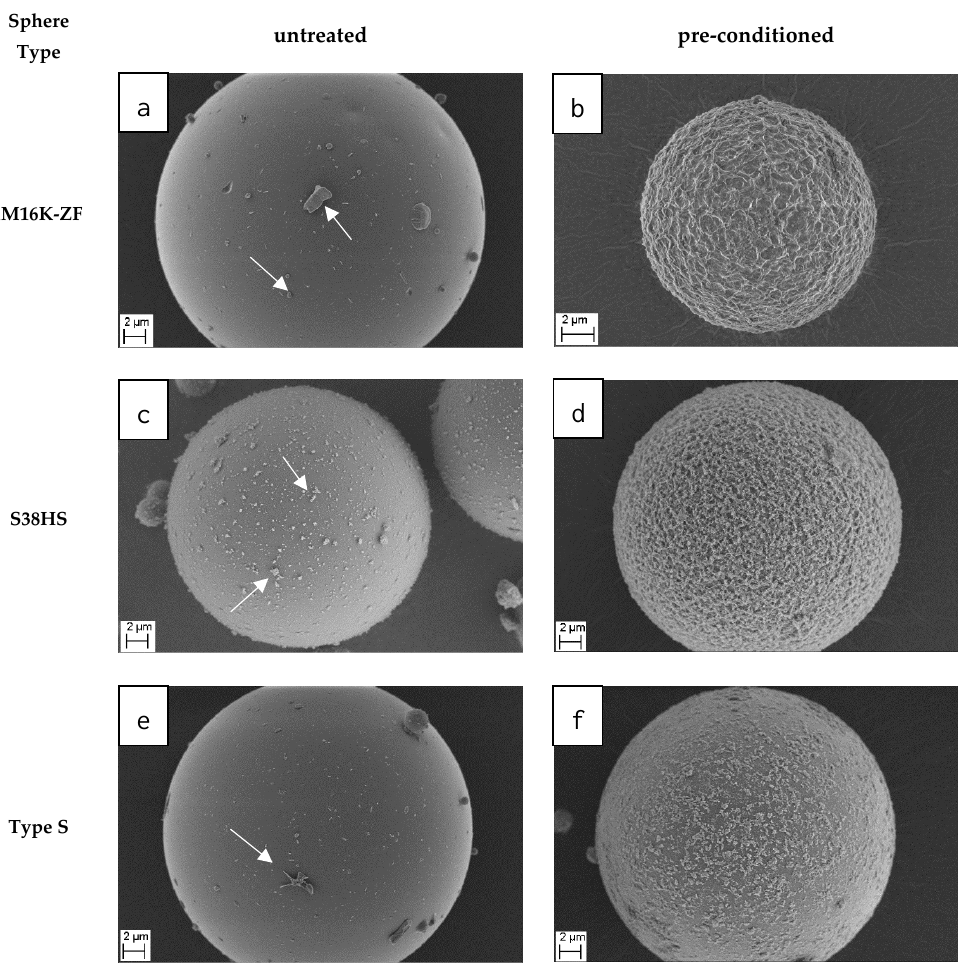
Figure 2. Comparison of untreated Micro Glass Spheres (MGS) and pre-conditioned MGS with Ca(OH) 2 . The white arrows indicate either impurities resulting from the manufacturing process, or in the case of the sphere type S38HS, the additional anti-agglomeration agent. After pre-conditioning, calcium silicate nanoparticles are deposited on the surface of each sphere type. In contrast to the